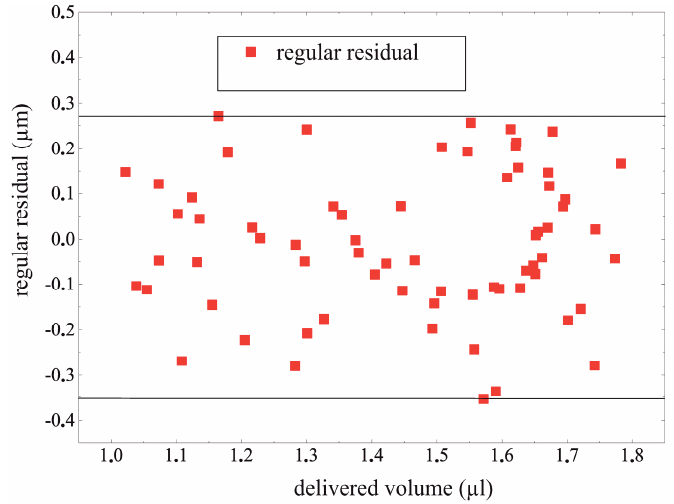
Figure 15. The regular residual of the dosing event between 1 and 1.8 μ L with a constant variance.